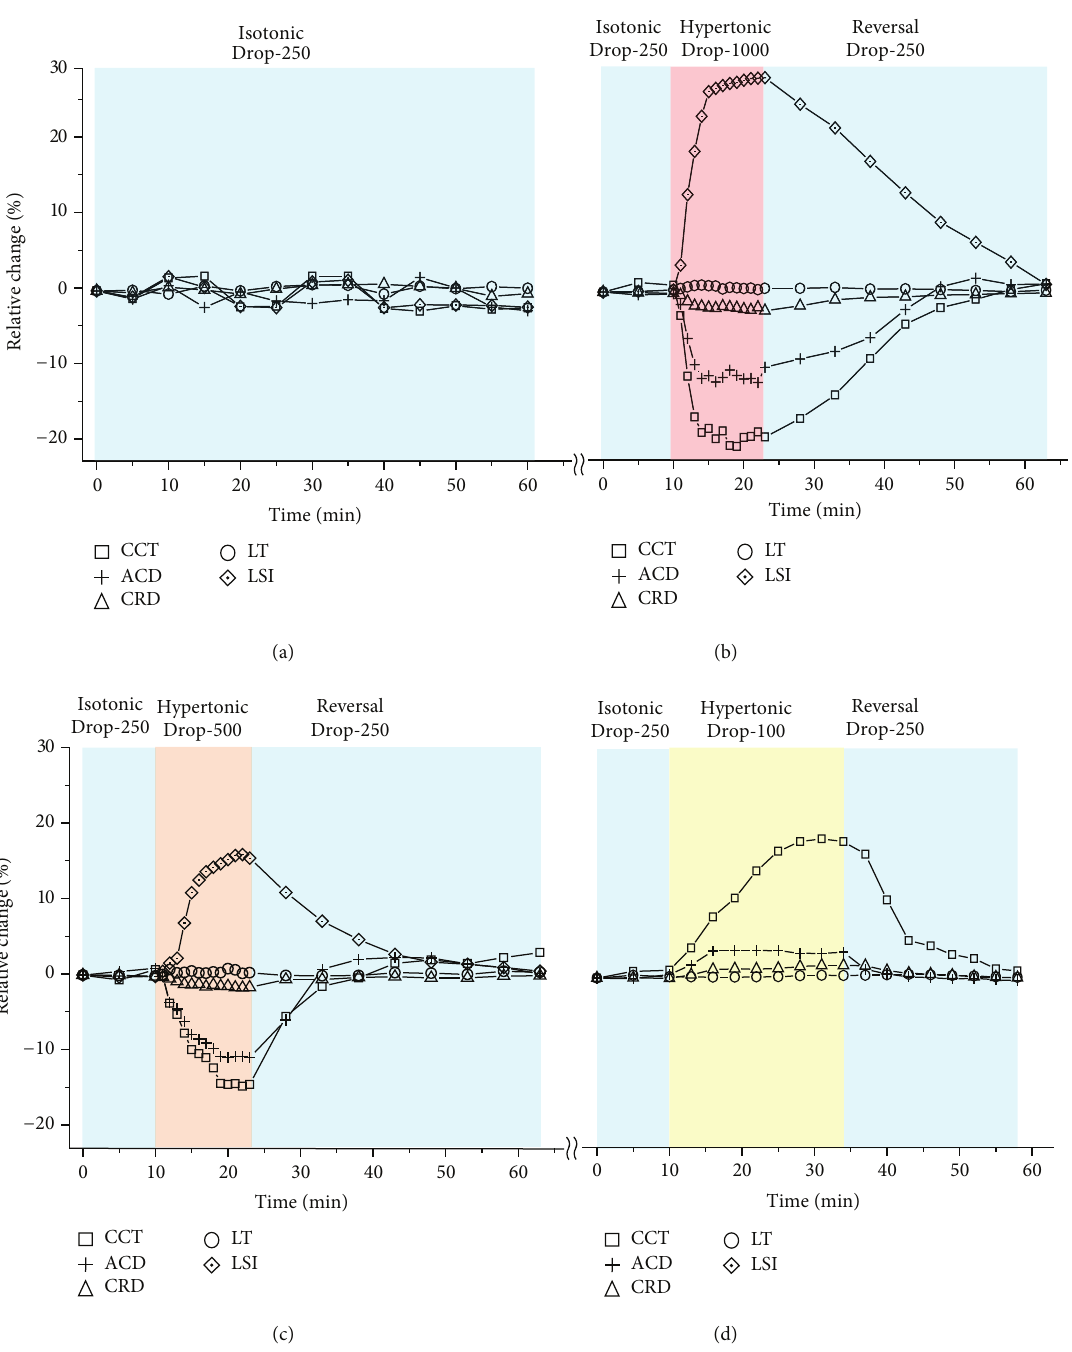
Figure 2: Normalized changes of cornea, lens, and retina in response to osmotic challenges. (a) Control group. (b) Hypertonic Drop-1000 challenge and reversal. (c) Hypertonic Drop-500 challenge and reversal. (d) Hypotonic Drop-100 challenge and